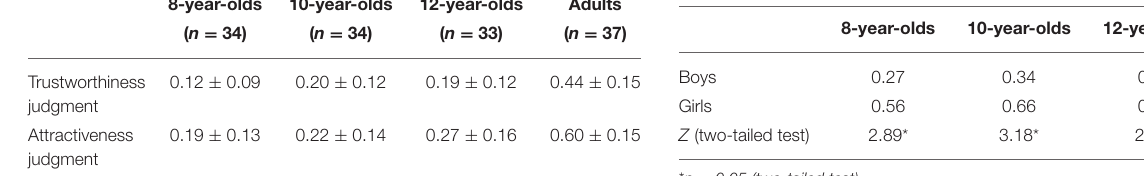
TABLE 3 | The Zr transformed from Pearson Correlation ( r ) between trustworthiness and attractiveness judgments in each age group for boys and girls.